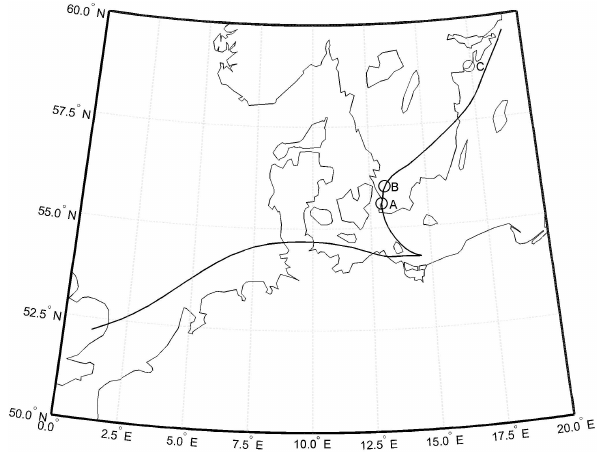
Fig. 3. Map with the air mass trajectory from the HYSPLIT model which was used when the urban plume from Malm ¨ o was modeled. The trajectory starts over England 48h upwind of Malm¨o. It ar- rives in Malm¨o 100ma.g.l. on the 21 June 2006, at 6a.m. Down- wind of Malm¨o (A) the trajectory moves northward over Sweden. About 3h downwind of Malm¨o the trajectory reach Vavihill (B) and 18h downwind of Malm¨o it passes near the background station As- pvreten (C)